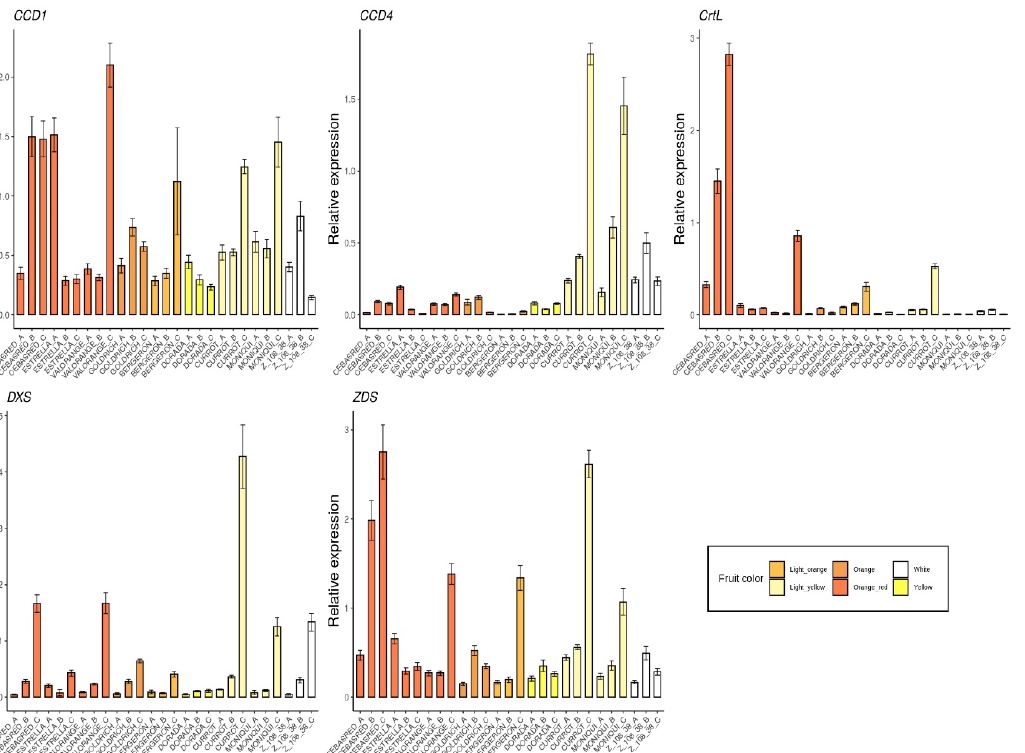
Figure 6. Expression dynamics barplots of the genes involved in carotenoids biosynthesis and degradation ( CCD1, CCD4, CrtL, DXS and ZDS ) in the nine cultivars ‘Bergeron’, ‘Cebasred’, ‘Currot’, ‘Dorada’, ‘Estrella’, ‘Goldrich’, ‘Moniquí’, ‘Valorange’ and ‘Z 108-38 ′ at three different ripening stages based on their skin ground color and firmness: green fruit (_A), during color change (_B) and at physiological ripening (_C).